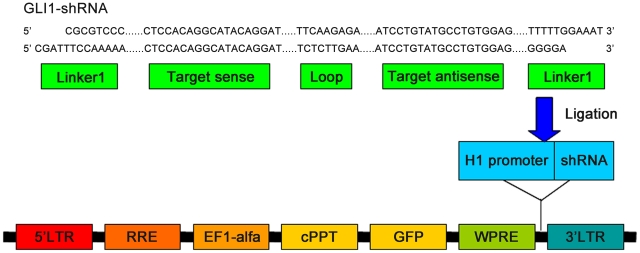
Construction of the pLVTHM vector encoding anti-GLI1 shRNA.For the GLI1-shRNA vector, two single strand DNAs encoding two linkers, the target sequences and a loop element, were synthesized. These were annealed to double stranded DNA, and ligated into the pLVTHM following MluI and CalI digestion. The short hairpin form of shGLI1 is expressed under the control of human H1 promoter. The vector also contains a human EF1-α promoter driving the GFP marker gene for tracking transduced cells. The vectors were generated by transient transfection of pRsv-REV, pMDlg-pRRE, pMD2G, and the shRNA encoding pLVTHM into 293T cells. Abbreviations: RRE, Rev response element; cPPT, central polypurine tract; EF1-α, human elongation factor 1-α promoter; H1, the human H1 promoter; GFP, green fluorescent protein; PRE, human hepatitis virus posttranscriptional regulatory element.